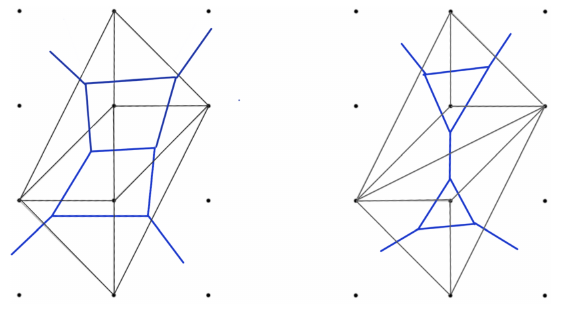
Figure 5. The toric Z 3